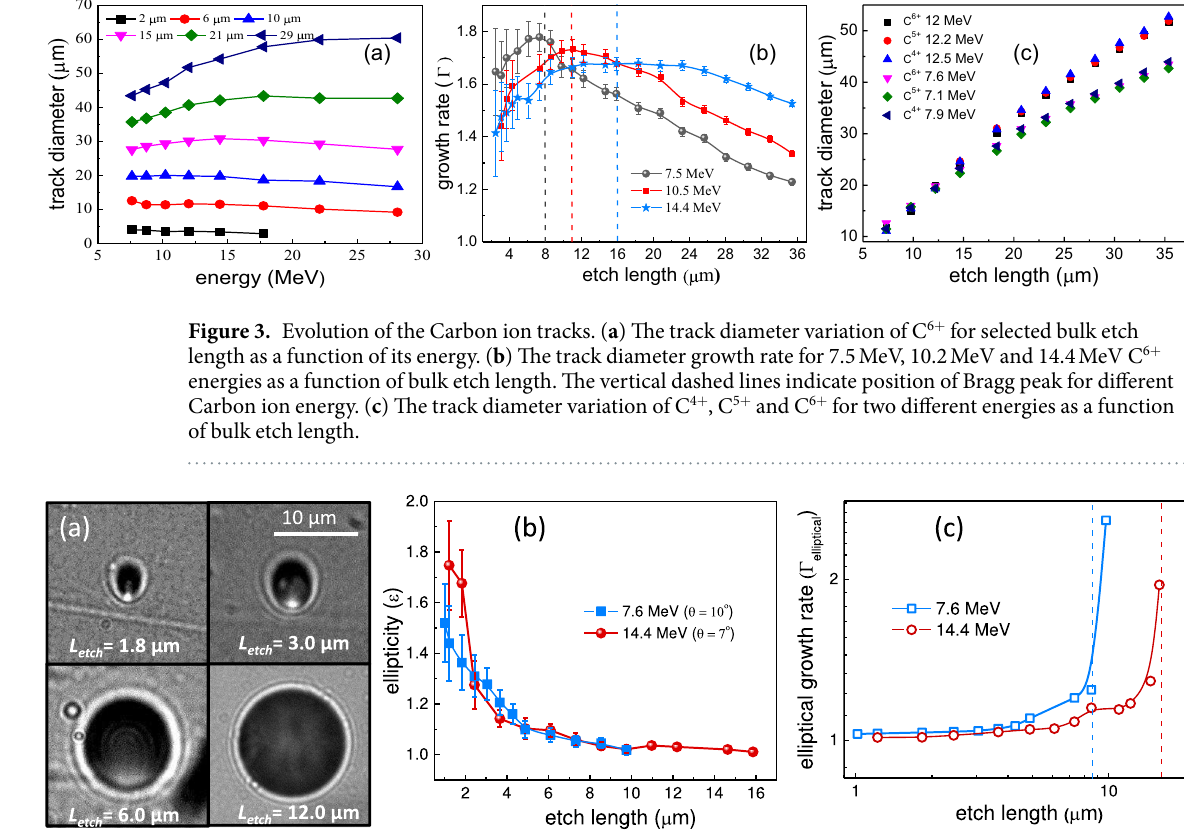
Figure 4. Elliptical tracks of obliquely incident Carbon ions. ( a ) Evolution of 7.6 MeV C 6 + ion tracks changing from elliptical (for small bulk etch length) to circular (for large bulk etch length) during the etching process. ( b ) Trend of track ellipticity for 7.6 MeV and 14.4 MeV C 6 + as a function of bulk etch length. ( c ) Bulk etch length dependent on growth rates of 7.6 MeV and 14.4 MeV C 6 + pits derived from their angle of incidence and ellipticity. The dotted lines indicate stopping range of 7.6 MeV (blue line) and 14.4 MeV (red line) Carbon ions.